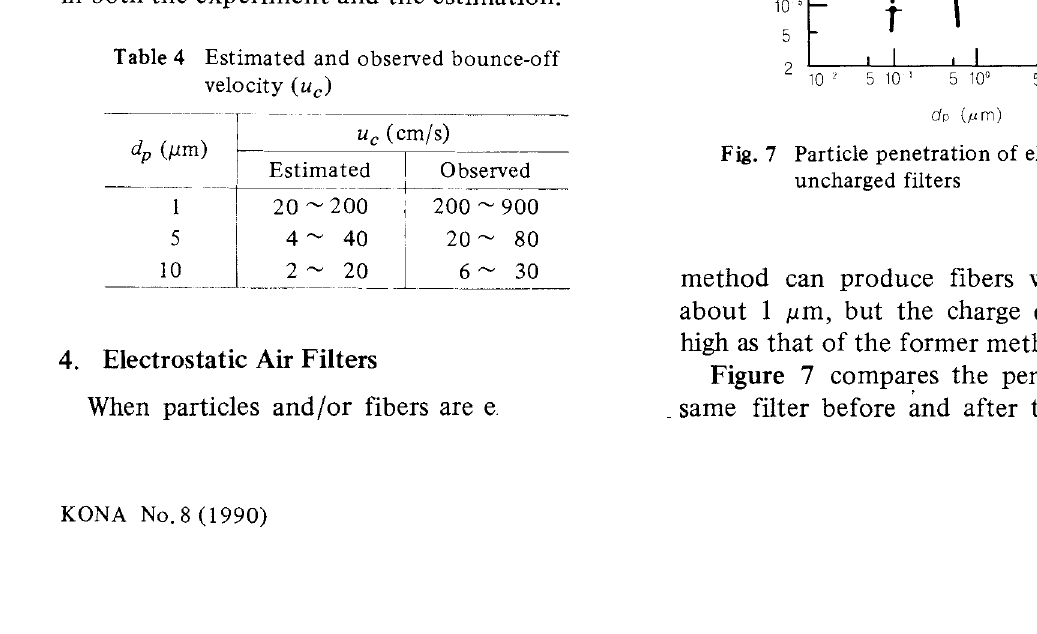
Fig. 7 Particle penetration of electret filters and uncharged